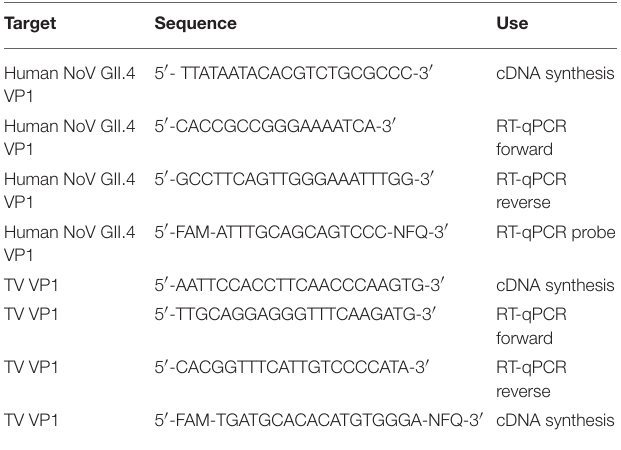
TABLE 1 | Human NoV and TV primers used for cDNA synthesis and